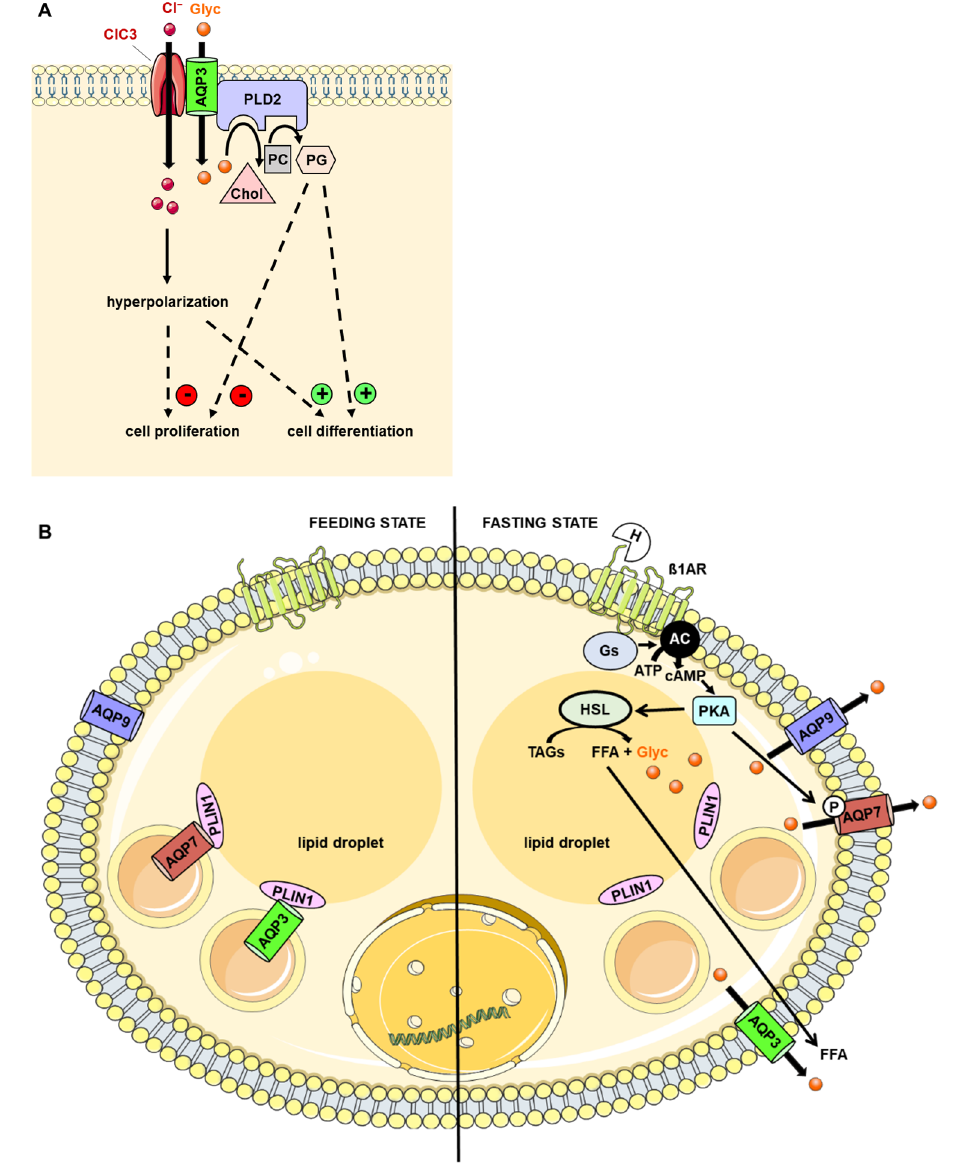
Figure 5. Role of the protein–protein interaction involving AQP3. ( A ) Role in keratinocyte differentiation. Upon glycerol entry through AQP3, glycerol is converted into PG by PLD2. PGly promotes growth arrest and differentiation of keratinocytes. ( B ) Role in adipocytes. PLIN1 interacts with AQP3 and AQP7 under feeding state. In fasting state, hormones, such as catecholamines, activate the ß-adrenergic receptor, which leads to a subsequent rise in cAMP and activation of PKA. PKA activates HSL hormone-sensitive lipase and thereby stimulates TAG degradation and Gly release. PKA also phosphorylates AQP7, which decreases it affinity for PLIN1 and enables its translocation to the plasma membrane. The AQP3–PLIN1 interaction is reduced by an unknow mechanism and leads to the translocation of AQP3 to the plasma membrane. AQP3 and AQP9 may only play a role in mouse 3T3-L1 adipocytes [101], but not in human or mouse white adipose tissue [109] . cAMP: cyclic adenosine monophosphate; Chol: choline; Glyc: glycerol; Gs: protein Gs; HSL: hormone-sensitive lipase; LIN-7: protein LIN-7 homolog; PC: phosphatidylcholine; PG: phosphatidylglycerol; PKA: protein kinase A; PLIN1: perilipin-1; PLD2: phospholipase D2; TAG: triacylglycerol.